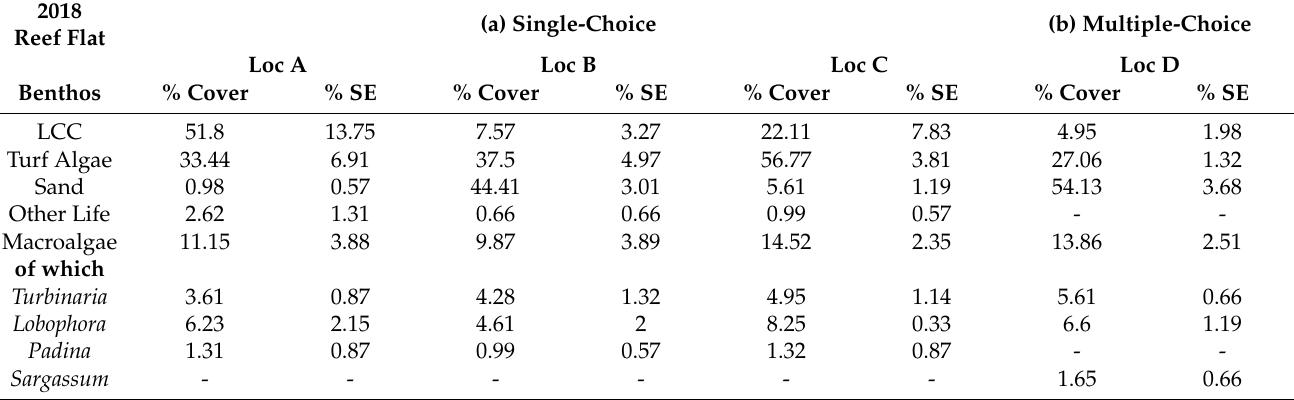
Table 2. Benthic community composition surveyed on the reef flat at locations of single-choice (loc A – C) (a) and multiple- choice assays (loc D) (b) in 2018. Given are % of total cover for live coral cover (LCC), turf algae, sand, other life and macroalgae, whereas macroalgae are split into the genera Turbinara , Lobophora , Padina and Sargassum . Replicate number n = 3 at each site.